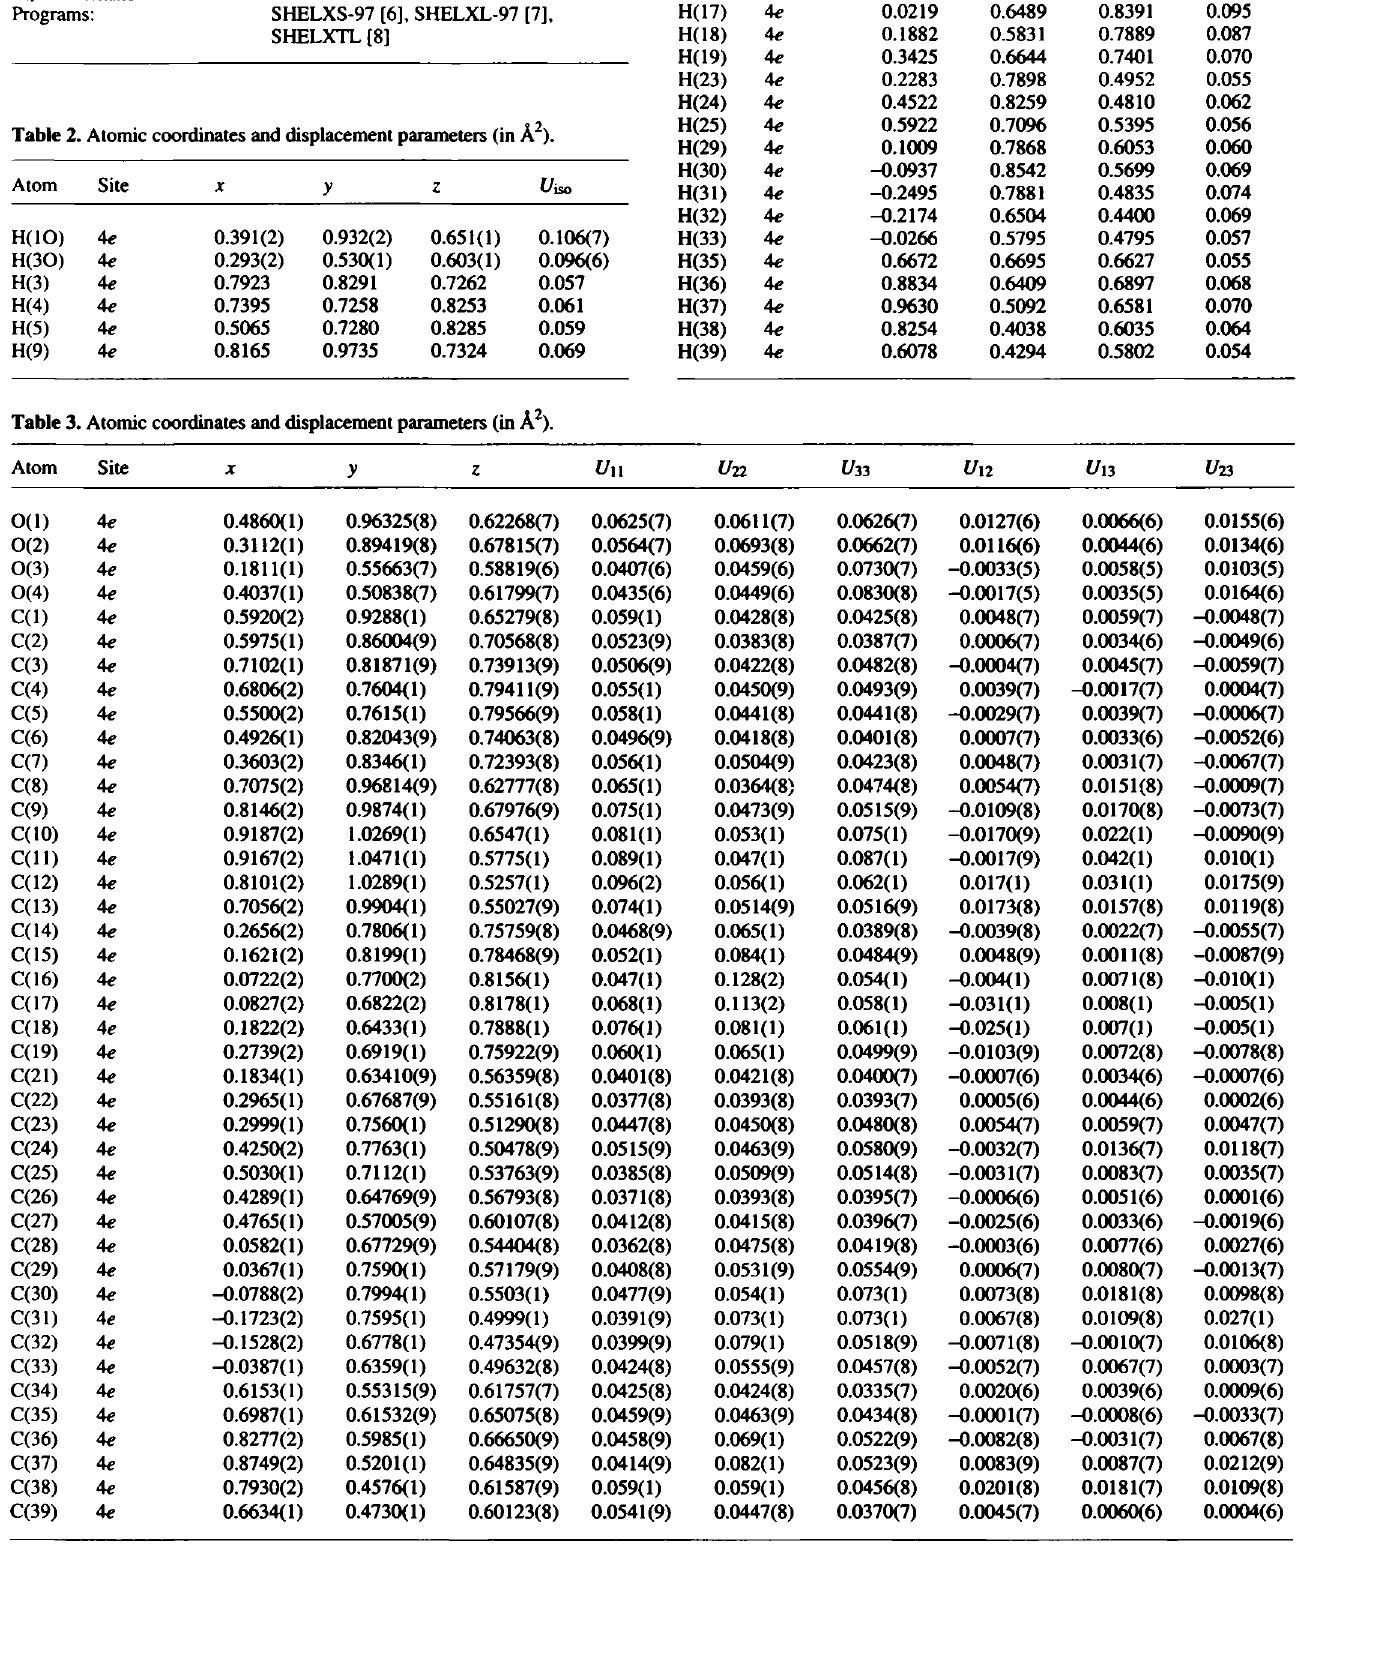
Table 3. Atomic coordinates and displacement parameters (in Â 2